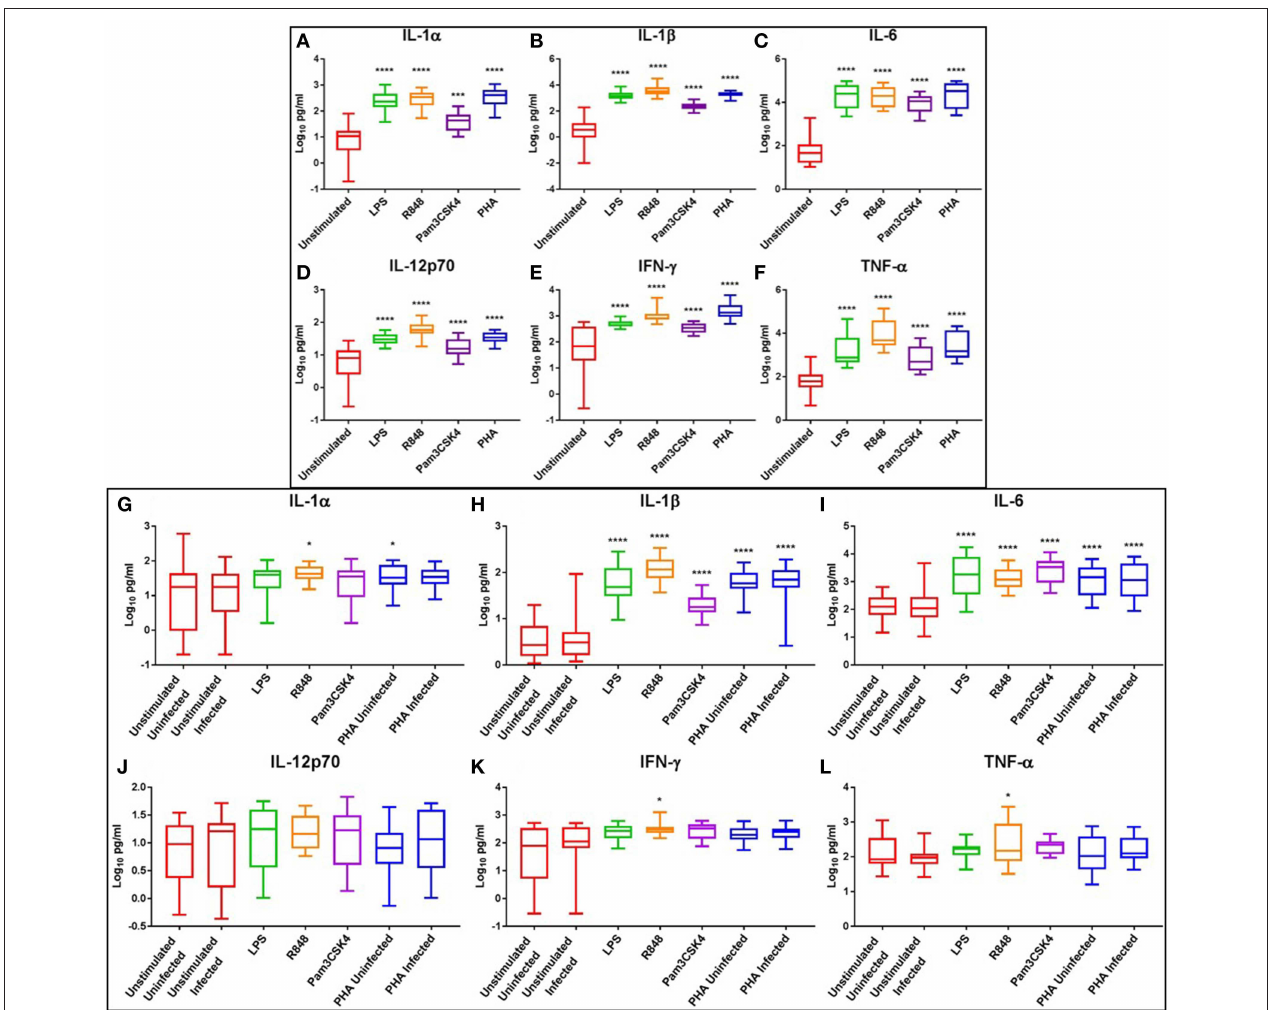
FIGURE 4 | Box and Whisker plots showing mean ± SD Log10 concentrations of pro-inflammatory cytokines IL-1 α (A,G) , IL-1 β (B,H) , IL-6 (C,I) , IL-12p70 (D,J) , IFN- γ (E,K) , and TNF- α (F,L) from unstimulated (red), LPS (green), R848 (orange), Pam3CSK4 (purple), and PHA (blue) conditions on day 3 prior to HIV infection (top box: A–F ) and day 5 post HIV infection (bottom box: G–L ). TLR agonists were used at a final concentration of 2 µ g/ml. PHA was used at a final concentration of 10 µ g/ml. All TLR stimulation conditions were infected. An ordinary one-way ANOVA with a Dunnett’s multiple comparisons test was performed. Significance